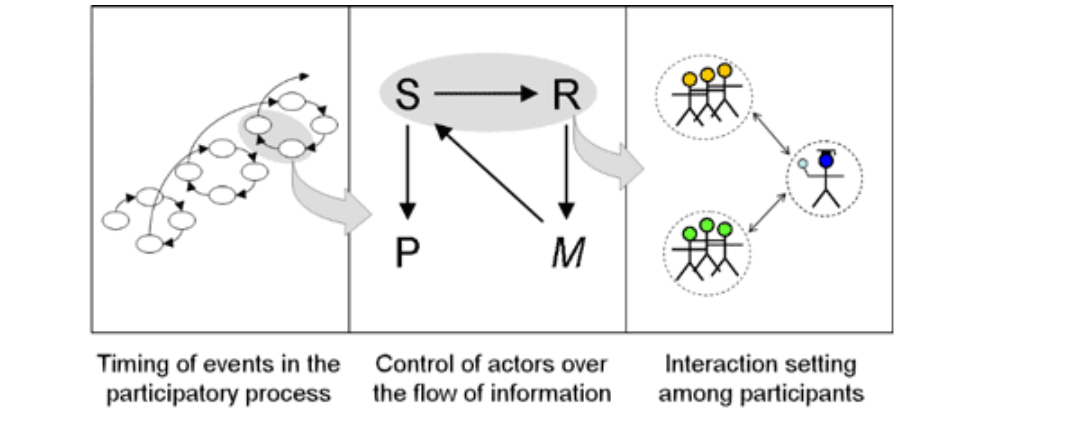
Fig. 3. Overview of the framework’s three facets to explain a participatory research